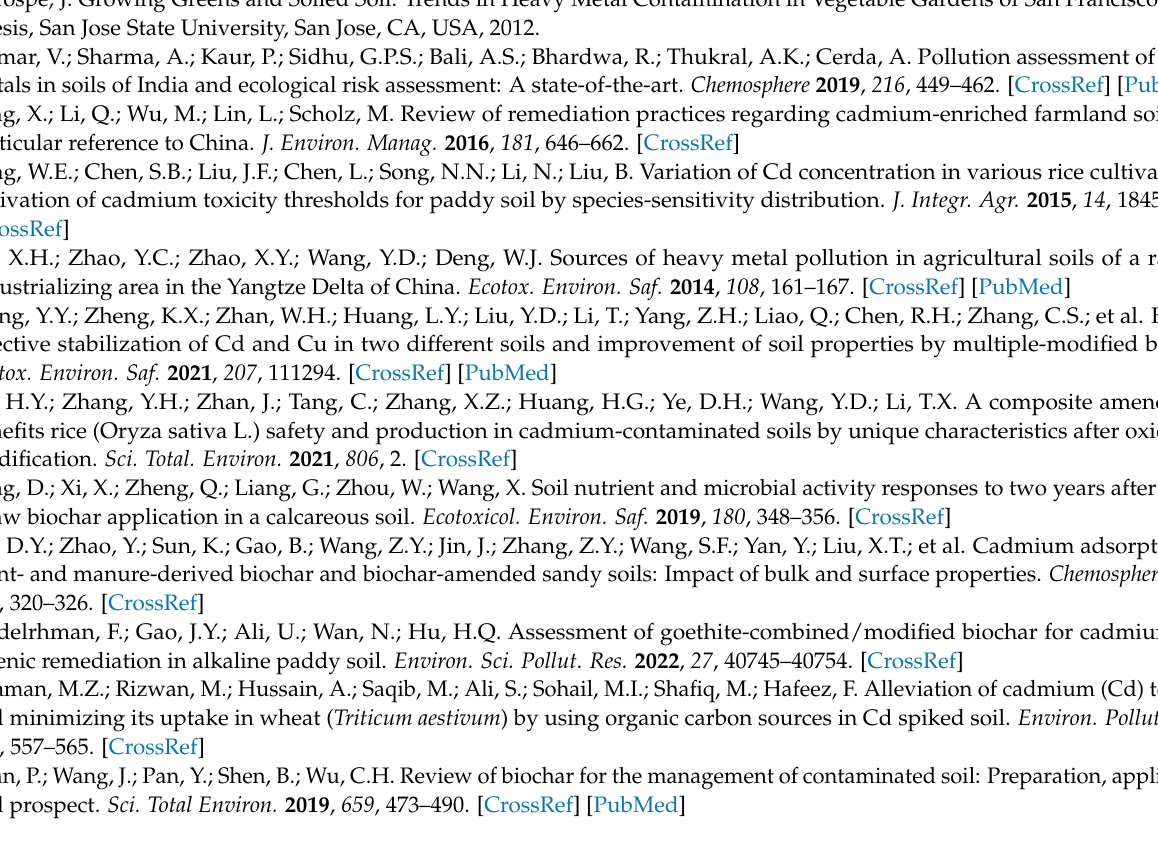
potassium. Figure S2: Effect of carbonaceous amendants on soil enzyme activity. (A) CAT, catalase enzyme; (B) Urea, urease enzyme; ACP, (C) acid phosphatase enzyme and (D) SUC, sucrase enzyme. Figure S3: Rarefaction curves. Figure S4: elative abundances of the top ten species with the highest abundances at the phylum level. Figure S5: Principal component analysis (PCoA) of soil bacterial community structure. Figure S6: Correlation between dominant microbial phyla, soil enzyme activity, and nutrients. Table S1: Physical and chemical properties of the tested soil. Table S2: Structure characteristics of carbonaceous amendants. Table S3: Analysis of correlation between microbial diversity, enzyme activity and soil nutrients. (* p < 0.05, ** p < 0.01, *** p < 0.001, and the same applies hereafter.) Table S4: Correlation analysis of physicochemical properties and Cd fractions of carbon-based porous materials. Table S5: Correlation analysis of soil physicochemical properties and Cd